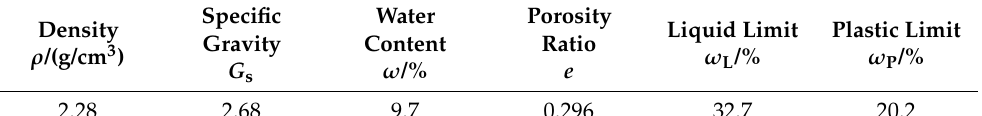
Table 1. Basic physical properties of weathered granite.